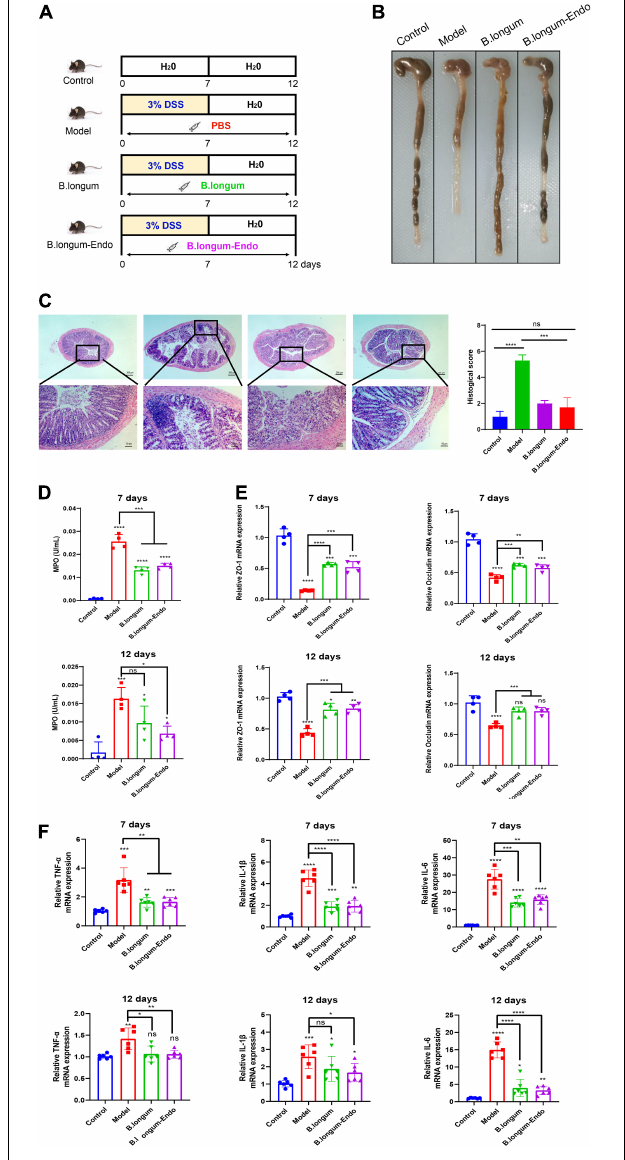
FIGURE 3 | B. longum-Endo administration further accelerates the recovery of DSS-induced acute inflammatory bowel disease in mice. (A) Schematic diagram of rehabilitation experimental model of acute colitis. The mice drank water normally for 5 days after taking 3% DSS for 7 days. (B) Representative photographs showing colon tissue. (C) Representative hematoxylin and eosin-stained sections of colon and histopathological scores. (D) Detection of myeloperoxidase (MPO) activity at days 7 and 12. (E) Detection of tight junction proteins ZO-1 and Occludin expression levels by qRT-PCR analysis at days 7 and 12. (F) Detection of proinflammatory cytokines TNF- α , IL-1 β , and IL-6 expression levels by RT-PCR analysis at days 7 and 12. Data are expressed as mean ± SD of three independent experiments ( n = 6–8). * P < 0.05, ** P < 0.01, *** P < 0.001, **** P < 0.0001, and ns: not